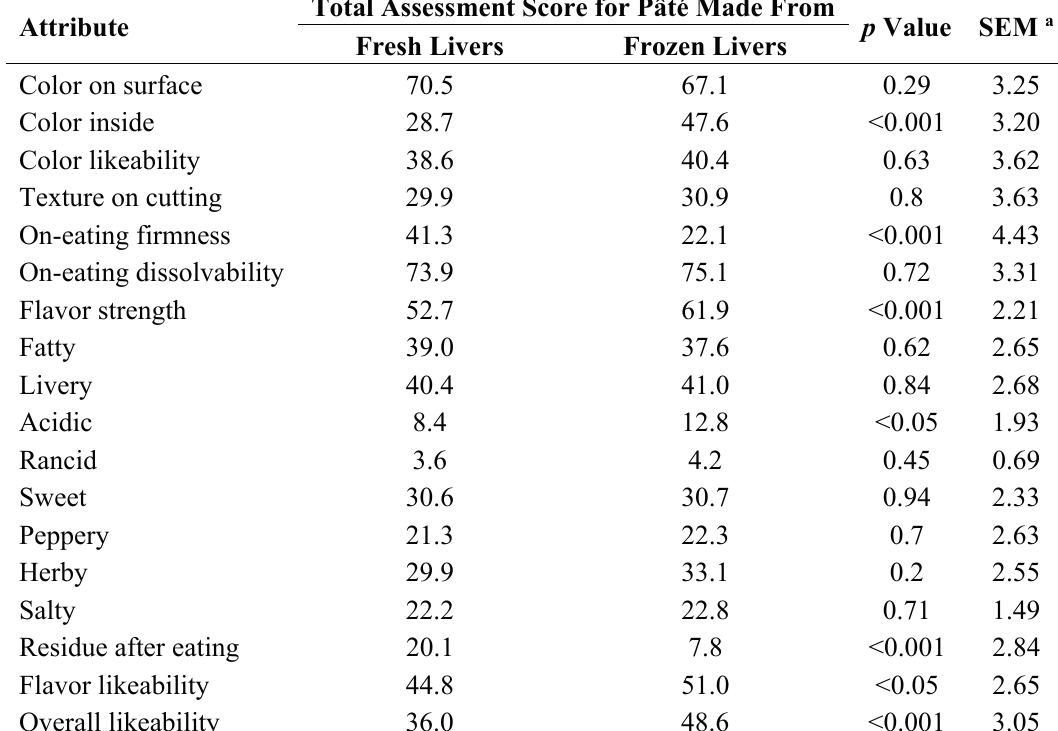
Table 1. Summary of the results of a sensory evaluation of pâté made from fresh and frozen livers undertaken by a professional taste panel. a Standard Error of the Mean